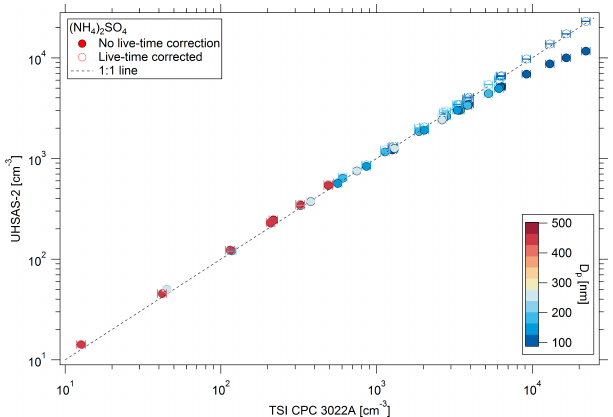
Figure 5. Relationship between the UHSAS-2 and the CPC particle number concentration (cm − 3 ) for nearly monodisperse (NH 4 ) 2 SO 4 aerosol of various sizes (>0.1µm) at ambient pressure. Dashed line represents 1 : 1 correspondence